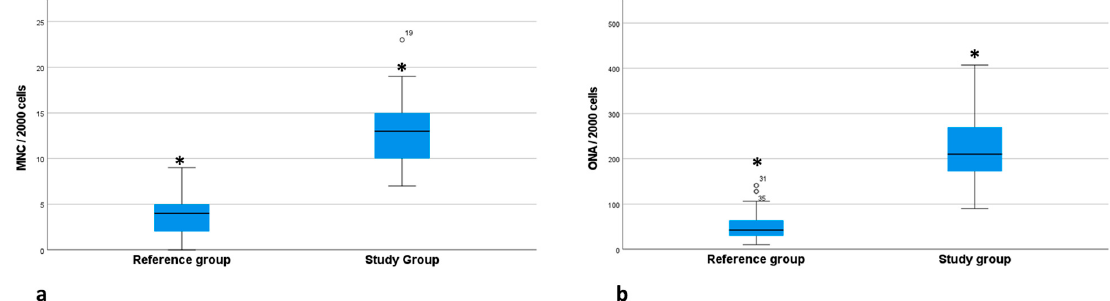
Figure 1. Box plots diagrams displaying the distribution of the frequency of cells with micronuclei (MNC) ( a ) and of cells with other nuclear anomalies (ONA) ( b ) per 2000 buccal epithelial cells in the study and reference groups. The line within the box corresponds to the median; thin vertical lines represent the minimum and maximum values; outliers ( ◦ ). Significant differences between groups (Mann–Whitney U Test, p ≤ 0.05) are indicated by the asterisk over the bars.